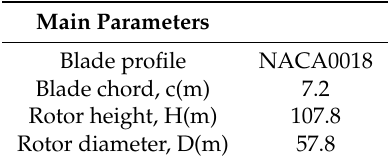
Table 1. Main parameters of the